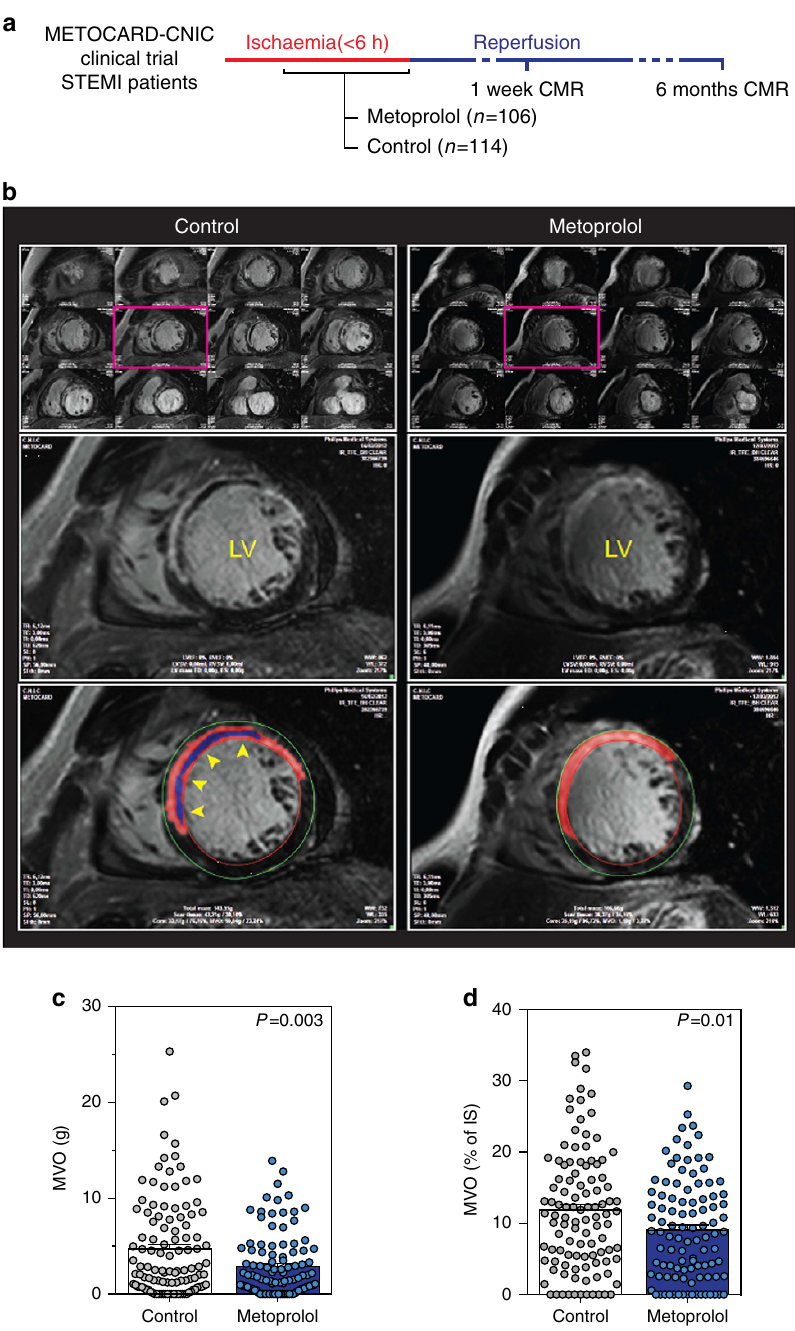
Figure 1 | Metoprolol administration during ongoing AMI reduces MVO in patients. ( a ) METOCARD-CNIC trial scheme: patients with ongoing ST-segment elevation myocardial infarction (STEMI) were recruited and randomized to receive metoprolol (15mg i.v. doses) or control before reperfusion. A total of 220 patients were evaluated for MVO by cardiac magnetic resonance (CMR) imaging 1 week after AMI and 202 patients for an additional CMR at long-term LVEF 6 months after AMI for ventricular function assessment. ( b ) Representative CMR exams (short-axis covering the entire left ventricle (LV) from base to apex), showing significant differences in 1-week MVO between a control patient (left) and a metoprolol-treated patient (right). Lower panels show detailed views of the boxed images, revealing MVO (blue area, automatic quantification), defined as the absence of contrast wash-in inside the delayed gadolinium-enhanced area (red, semiautomatic quantification). Yellow arrowheads indicate MVO in the LV wall. ( c ) Quantification of MVO in grams of left ventricle. ( d ) Quantification of MVO relative to the infarcted area (%). Dots represent values for individual patients: 114 in the control group (grey) versus 106 in the metoprolol group (blue). Data are means ± s.e.m. and compared by unpaired Student’s t